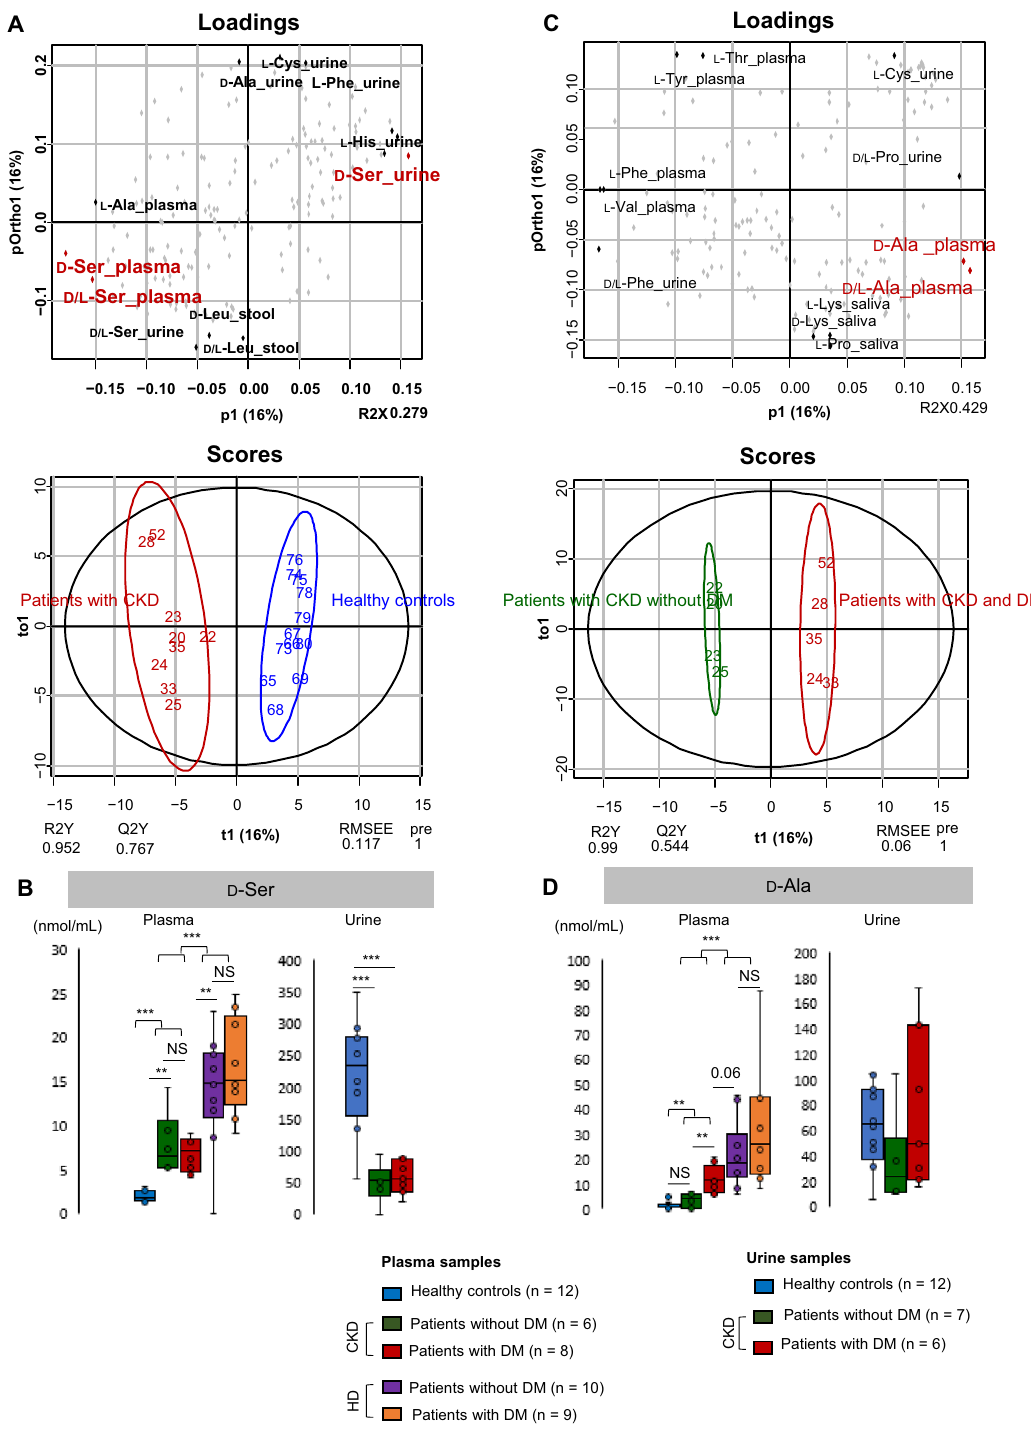
Figure 1. Association between D-serine (D-Ser) and d-alanine (D-Ala) profiles and kidney diseases. ( A ) Orthogonal projection to latent structures discriminant analysis (OPLS-DA) plots for patients with CKD compared with healthy controls. ( B ) Plasma and urine levels of D-Ser in patients with kidney diseases and healthy controls. ( C ) OPLS-DA plots for patients with CKD and DM compared with those without DM. ( D ) Plasma and urine levels of D-Ala in patients with CKD with and without DM and in healthy controls. * p < 0.05, ** p < 0.01, *** p < 0.001 (one-way ANOVA). NS not significant, CKD chronic kidney disease, DM diabetes mellitus, HD